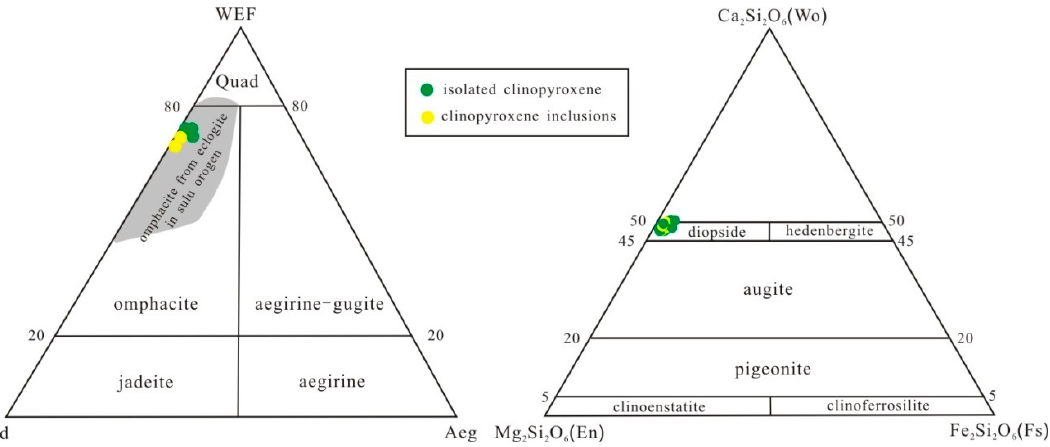
Figure 3. Classification diagrams for clinopyroxene [34]. Jd (Jadeite) = 100 × Al VI /(Na + Ca), Aeg (Aegirine) = 100 × (Na − Al VI )/(Na + Ca), WEF (wollastonite + enstatite + ferrosilite) = 100 − Jd − Ae.